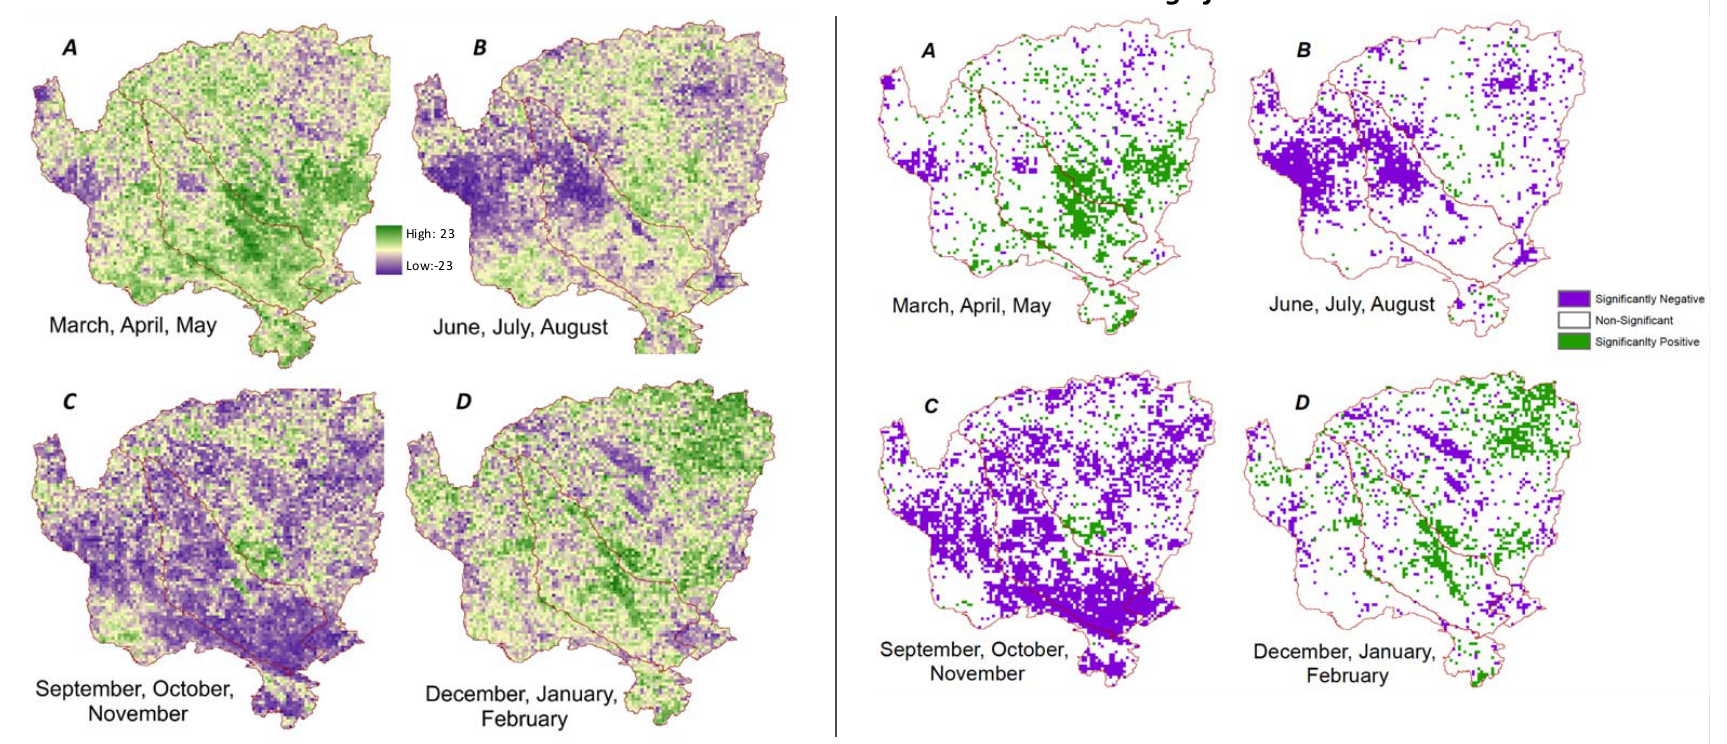
Figure 4. Vegetation persistence analyses for 1987–2010 compared to the baseline conditions for 1982–1986, across seasons ( A ) MAM, ( B ) JJA, ( C ) SON, and ( D ) DJF. The red boundaries outline the different drainage basins across the study area. Part I shows all the persistence values across the study area; whereas, part II shows the significantly positive or negative persistence values only.